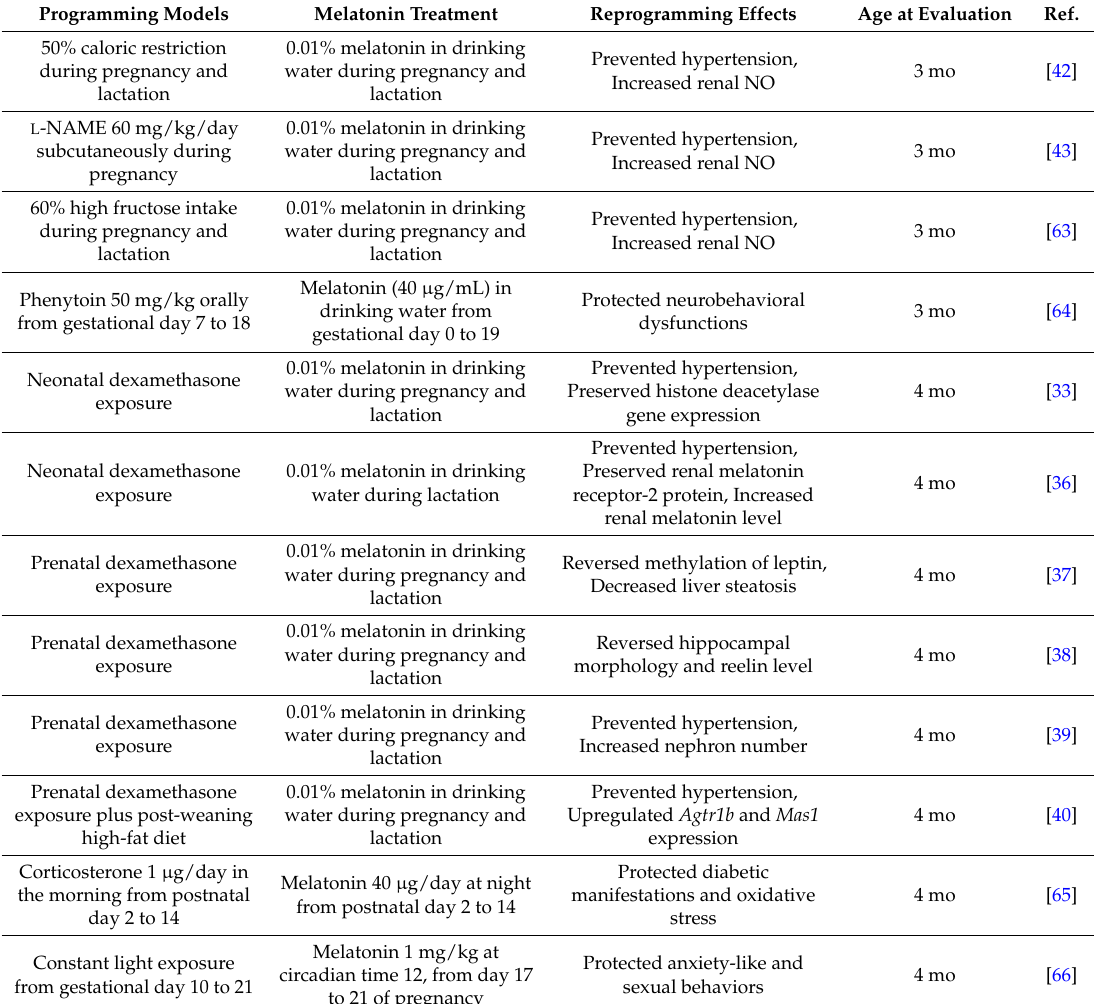
Table 1. Effects of melatonin on developmental programming in various animal